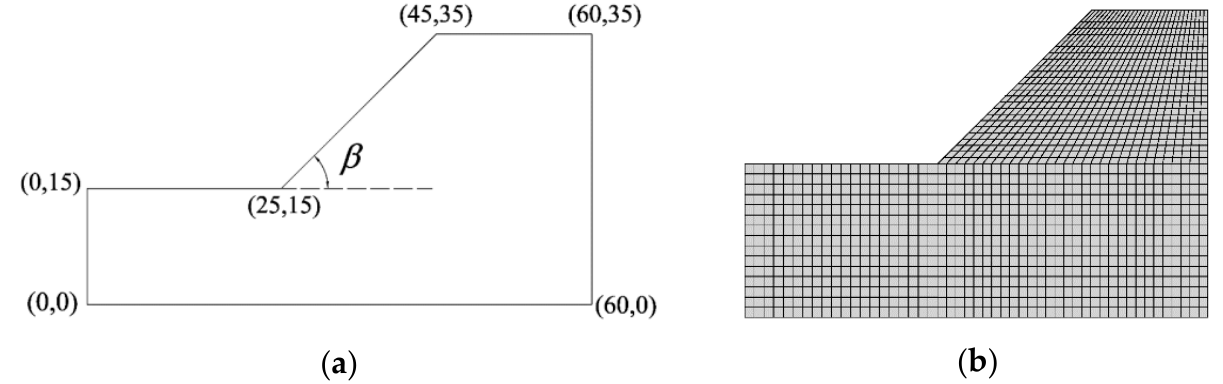
Figure 4. Geometry and adopted mesh. ( a ) geometry; ( b ) adopted mesh.